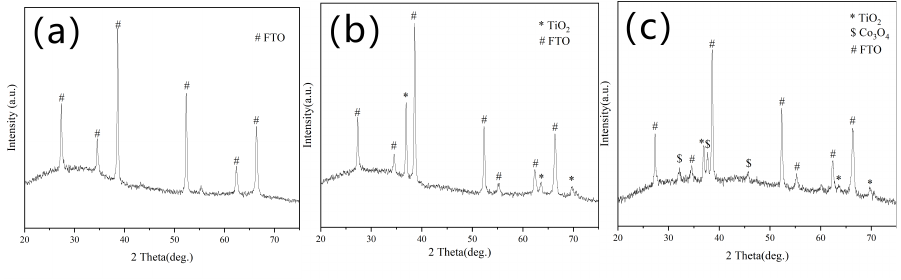
Fig. 2. XRD patterns of (a) FTO ,(b) the TiO 2 nanocones and (c) Co 3 O 4 @TiO 2